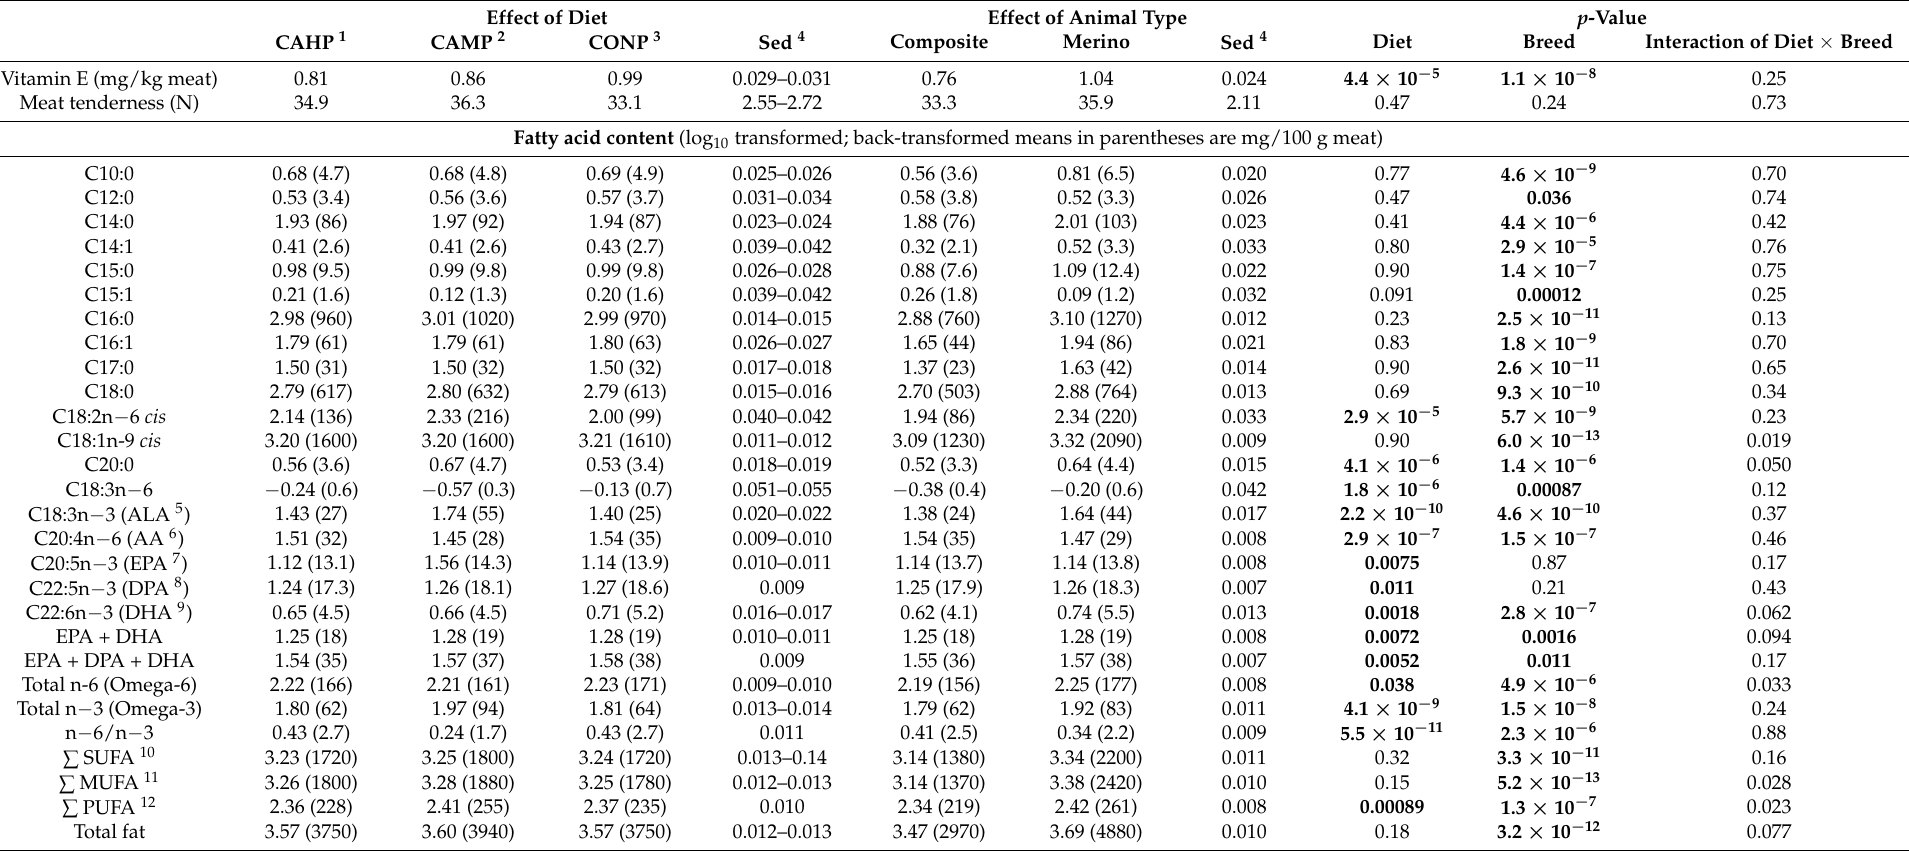
Table 2. Effect of diet and animal type on vitamin E concentration, meat tenderness and individual and major group fatty acids in muscle longissimus lumborum . Fatty acid concentrations reported in parentheses are reported in mg/100 g meat from back-transformed log 10 mean fatty acid